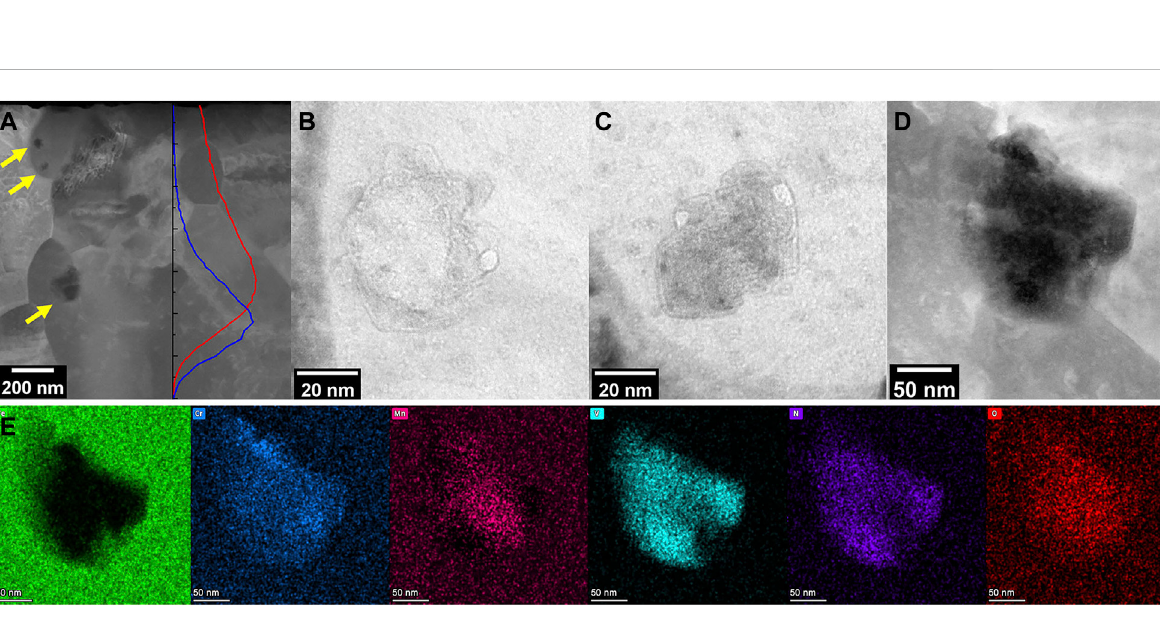
FIGURE 11 (A) HADDF image showing three precipitates in the irradiated area. Large precipitates are indicated with arrows and the dpa and implanted Fe ions distribution along depth are shown as lines in red and blue. (B,C) Bright fi eld images of the upper precipitates. (D) HADDF image of the precipitates at the depth of damage peak. (E) EDS elemental mapping of the large precipitate in (D)